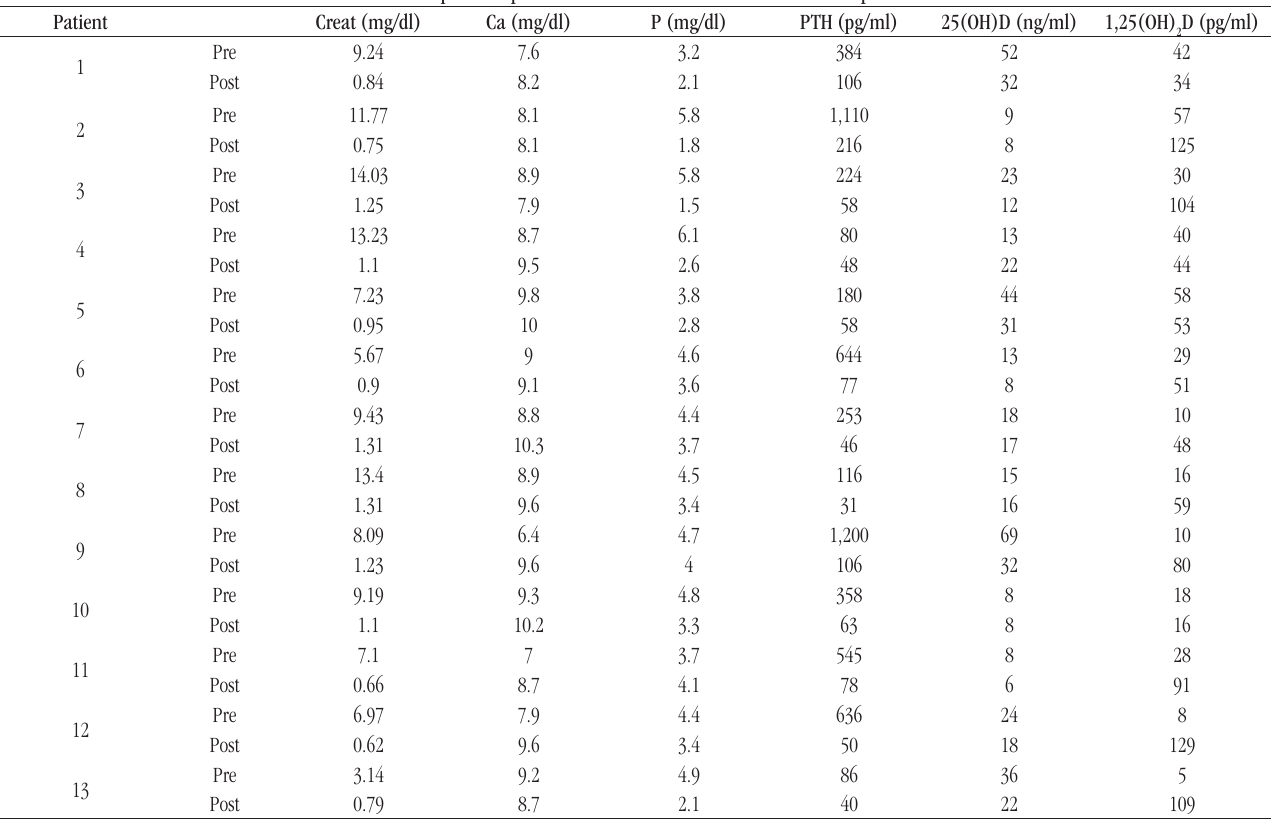
taBLE 1 − Serum concentrations of creatinine, calcium, phosphate, PTH, 25(OH)D, and 1,25(OH) in immediate pre-transplantation and three months after renal transplantation